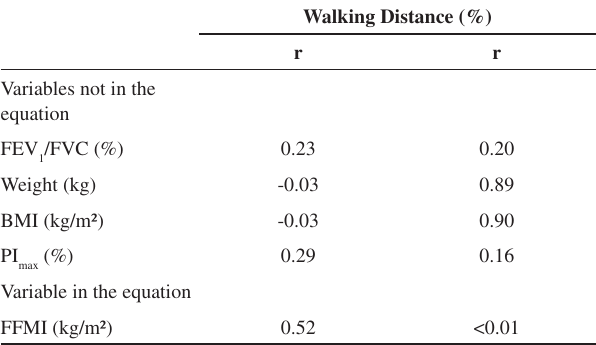
Table 3 - Partial correlations obtained with backward multiple regression analysis.